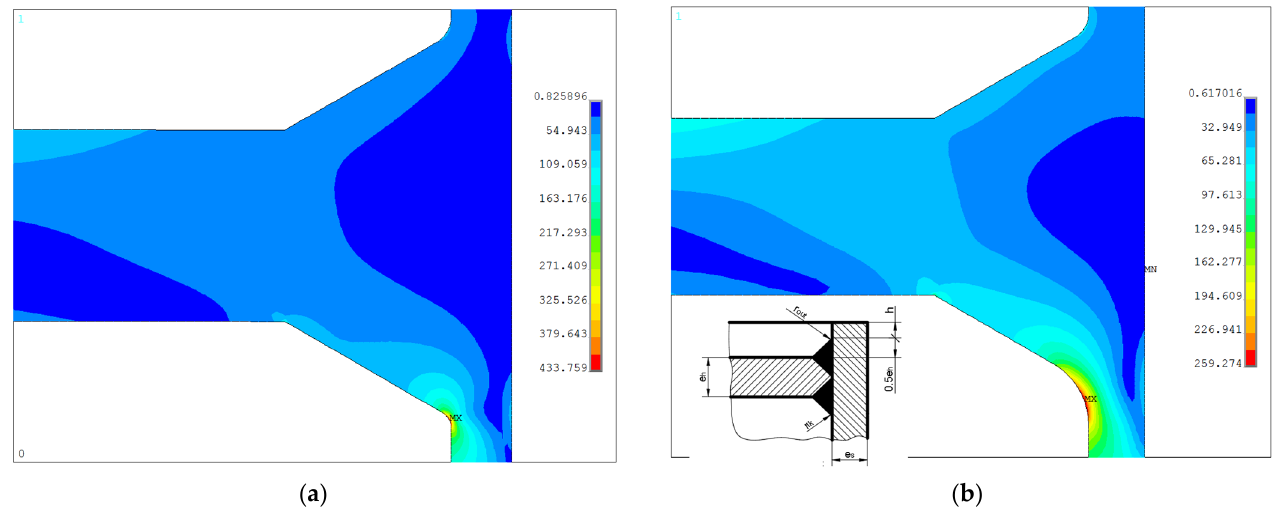
Figure 24. Bottom type “h”: ( a ) distribution of equivalent stresses in the groove for r ik = 6 mm; ( b ) distribution of equivalent stresses in the groove for r ik = 25 mm.